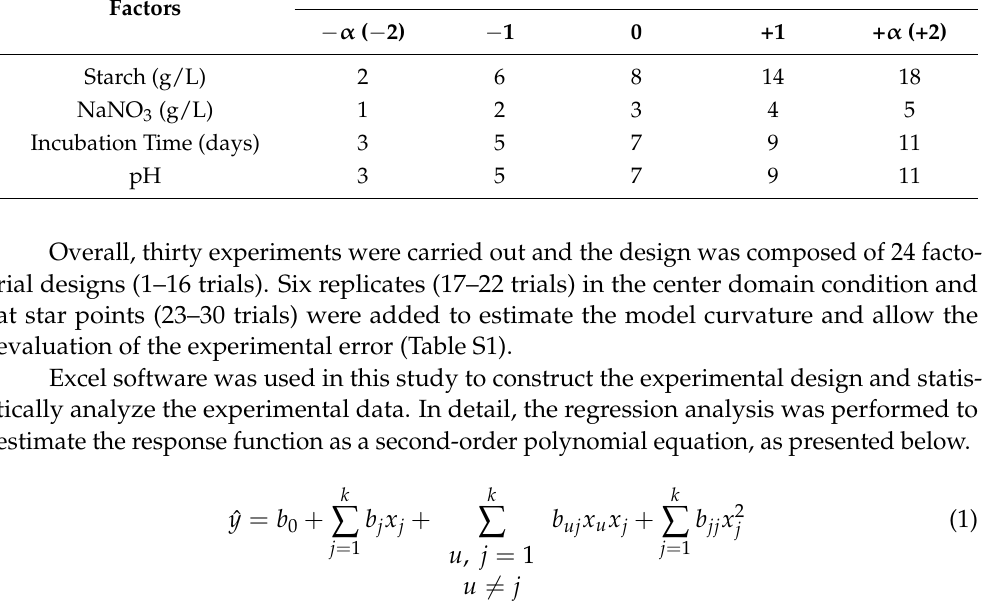
Table 1. Coded and actual values of the variables for central composite experimental design. Factors − α ( − 2) − 1 Starch (g/L) NaNO 3 (g/L) Incubation Time